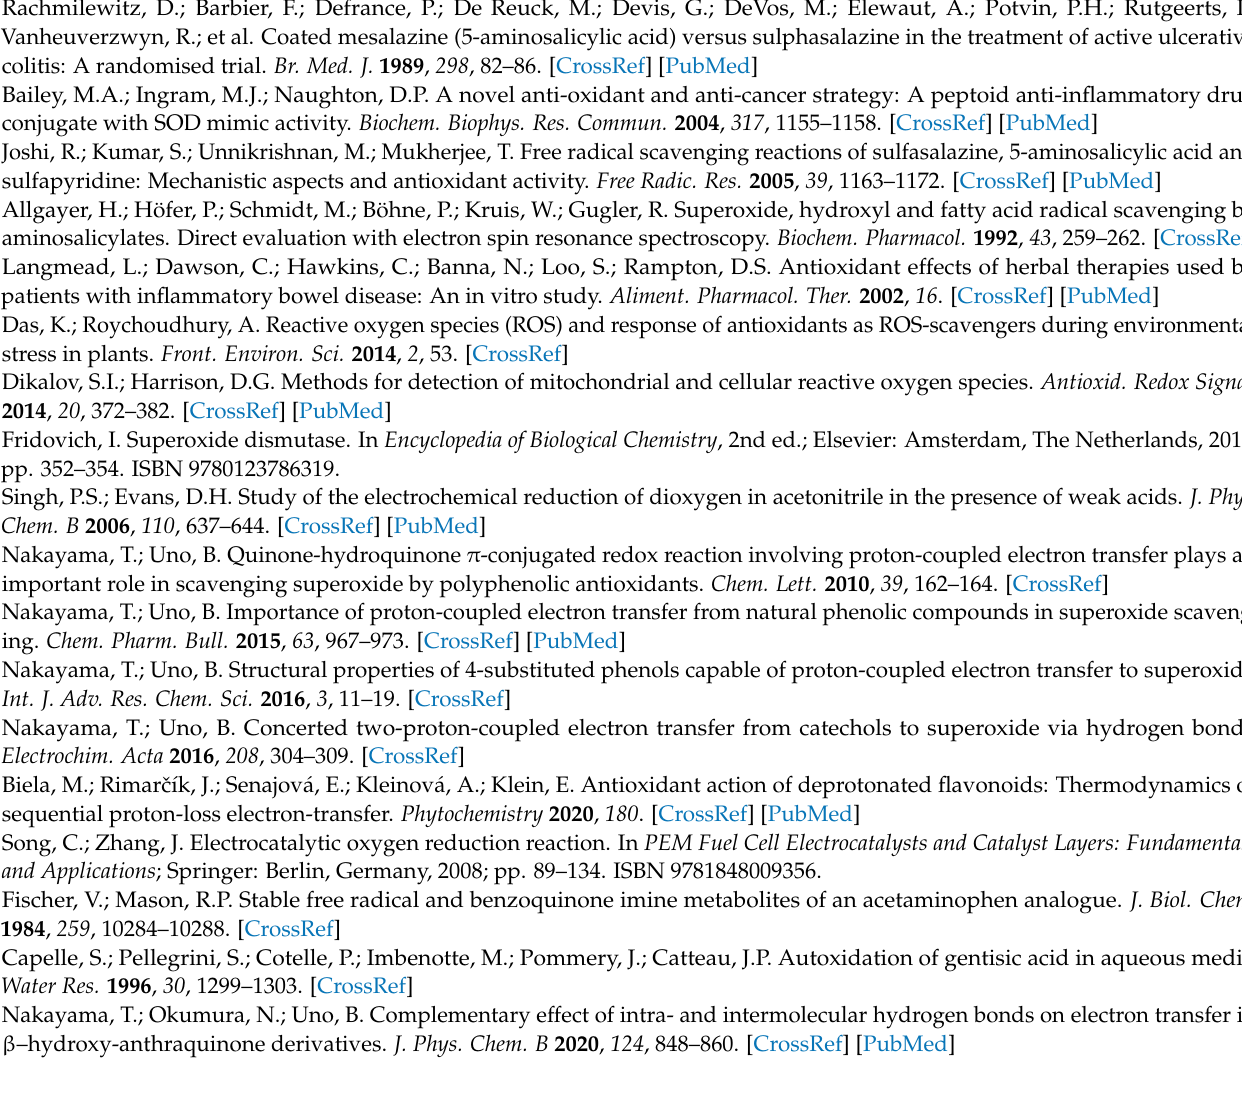
cal phenolic compound), Figure S2: In situ electrolytic ESR system, Table S1: Charge distributions and sis, Table S2: Charge distributions and natural population on 5-ASA a , 5-ASA b , and deprotonated 5-ASA anion obtained by the NBO